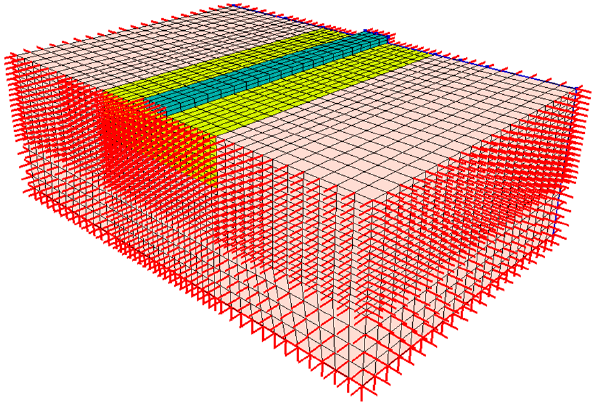
Figure 14. The FE model of a strip foundation resting on a three-dimensional random subsoil. Probabilistic analysis requires multiple repetitions of similar computations; it is a significantly time-consuming process, so assuming an optimal refinement of the finite element mesh is necessary. Division of the subsoil into a given number of elements should ensure the desired result accuracy, also providing a relatively short calculation time of a single case. Therefore, the subsoil volume under the foundation is divided into several sub-volumes, variable in the degree of finite element mesh condensation (Figure